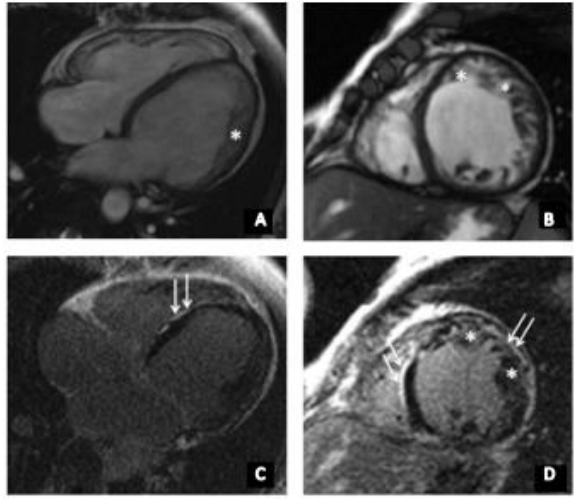
Figure 2. ( A – D ) cardiac MRI of index patient (II-2). * indicates non-compact myocardium (up to 18 mm). ( A ) Long-axis four-chamber projection, steady state free prcession (SSFP), and ( B ) short axis, SSFP, ( C , D ) Late gadolinium enhancement , areas of non-ischemic (subepicardial) contrast enhancement of left-ventricular walls are indicated with the white arrows.